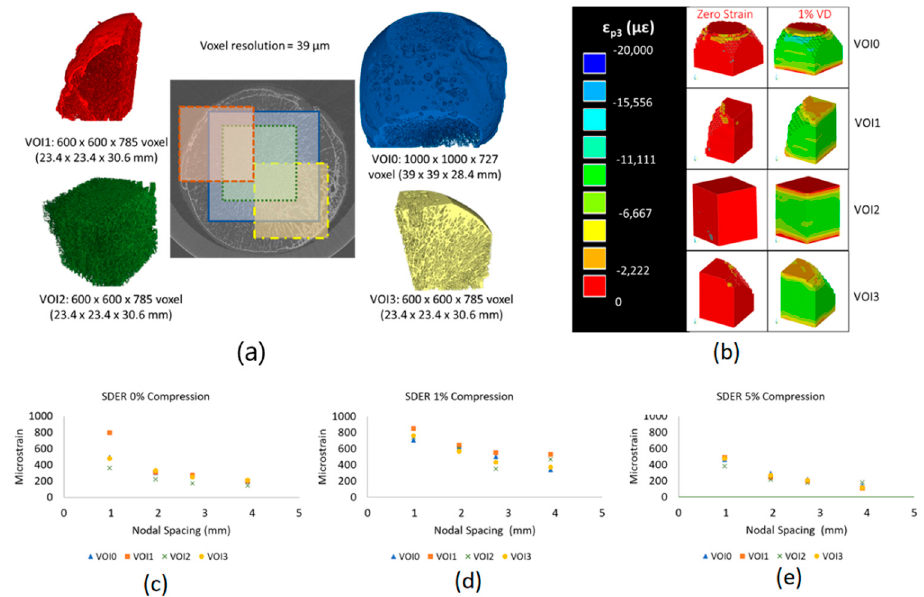
Figure 3. ( a ) Volumes of interest (VOIs) were extracted from one of the OA specimens to evaluate uncertainties within a representative total volume (blue), central region in the trabecular bone (green) and regions containing cysts (red) and sclerotic bone (yellow). ( b ) DVC strain fields for the four VOI’s under zero-strain (repeated images) and 1% virtual compressive apparent strain (1% VD). ( c – e ) Little di ff erence in the measures of standard deviation of the error (SDER) measures was observed across each of the four VOI’s, and with nodal spacings equivalent to 1.01, 1.95, 2.73 and 3.90 mm under each of the 0% compression and 1% and 5% virtual compressive apparent strain cases. Table 2. Mean Absolute Error (MAER) and Standard Deviation of the Error (SDER) across all VOIs for the 3 di ff erent loading conditions considered for a NS equal to 50 voxels (1.95 mm). MAER ( µε ) Range MAER (µ ε )